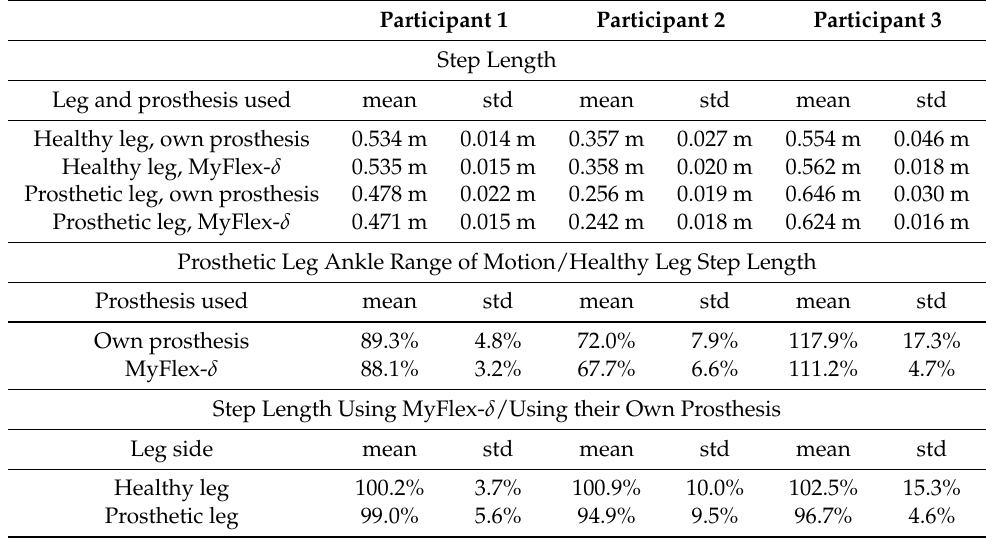
Figure 15. Procedures for the calculation of: ( a ) the ratio between the step length measured from the prosthetic leg and the healthy leg; ( b ) the ratio between the step length measured while using MyFlex- δ and while using a participant’s own prosthesis. Table 7. Step Length. Mean values (mean) and standard deviations (std) are calculated from 50 gait